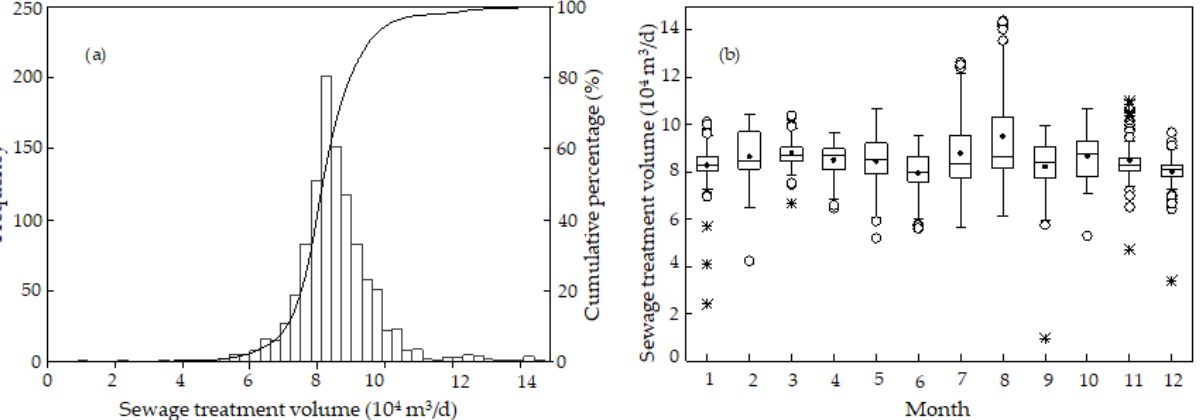
Figure 2. ( a ) Probability and ( b ) monthly distributions of daily average sewage treatment volume. In ( b ), the five horizontal lines in each box represent the five percentile points. The horizontal line on the lower surface represents the lower value; the lower end of the box represents the 25th percentile value (p25); the line segment in the box represents the median value; the top of the box represents the 75th percentile value (p75); the top horizontal line represents the largest value. The solid circle ( • ) represents the average. Outliers are marked by a hollow point ( ◦ ) and extreme points are marked by an asterisk